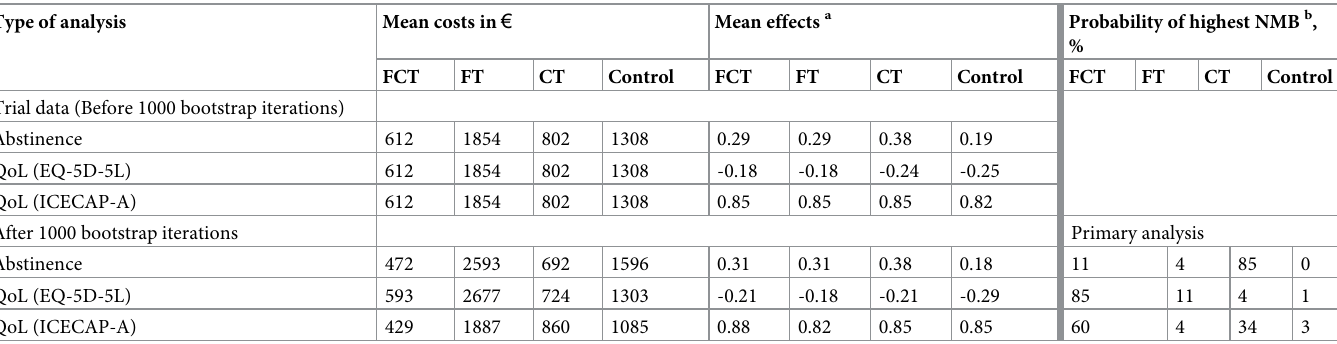
Table 2. Mean costs & effects per study group at 6-month follow-up (primary analysis). Type of